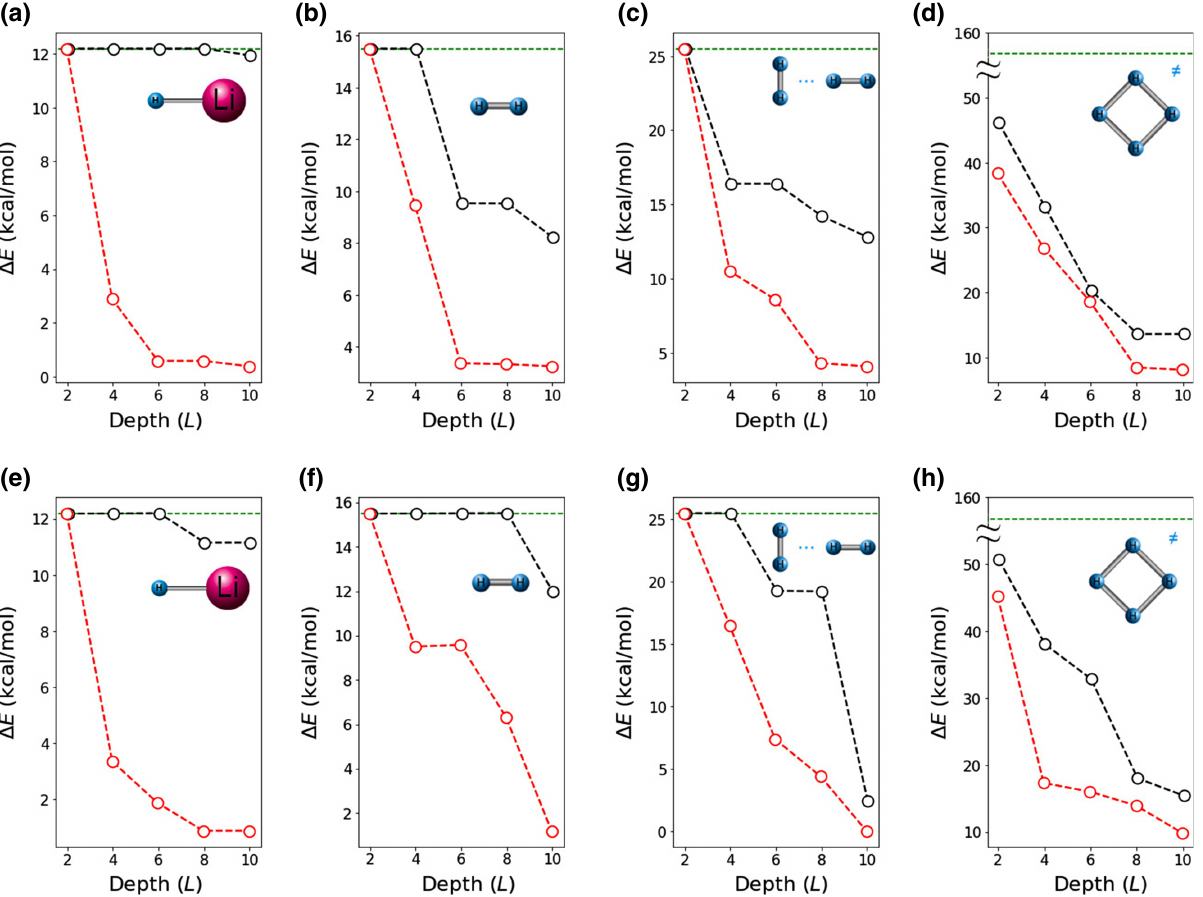
FIG. 5. Proof-of-principle energy error (cid:7) E = E VQE − E exact versus ansatz depth L for various molecular species based on default (black) and permuted qubit Hamiltonians (red) built from the exact wave functions. (a)–(d) and (e)–(h) show the cases for the hardware- efficient RyRz and Ry ansatz, respectively. Dotted green lines correspond to pseudo-correlation energy (cid:7) E PC = E HF − E exact